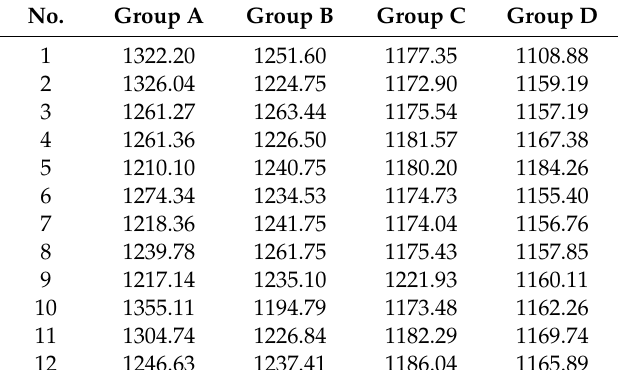
Table 2. The density of briquettes with different particle sizes (kg/m 3 ).